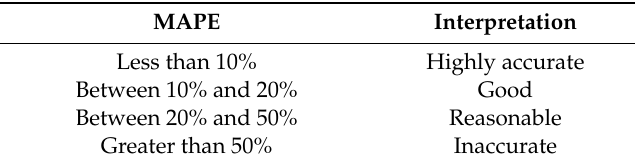
Table 4. The guidance for the interpreting of mean absolute percentage error (MAPE) results by Lewis